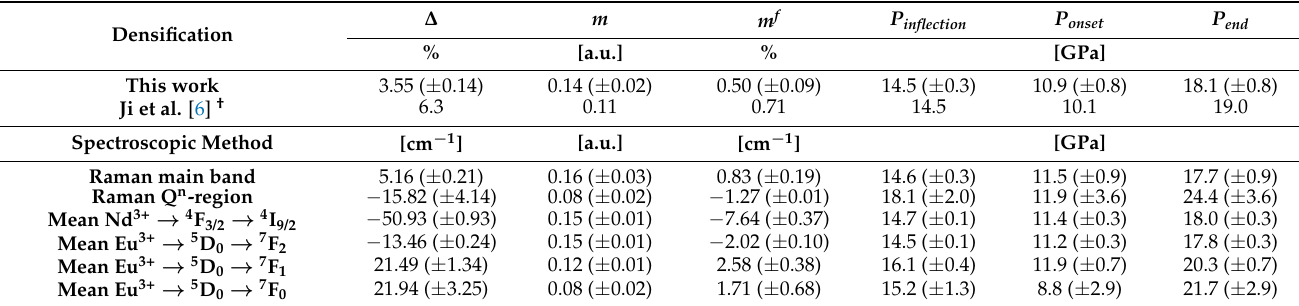
Table A1. Sigmoidal fitting parameters (Equation (5)) for densification and various spectroscopic methods in relation to the mean I and P max .